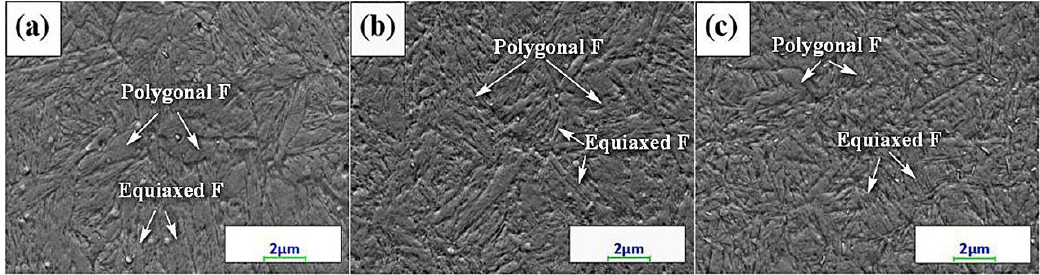
Figure 6. SEM micrographs of tempered specimens: ( a ) Q-T process and austempering process ( b ) without and ( c ) with CR.